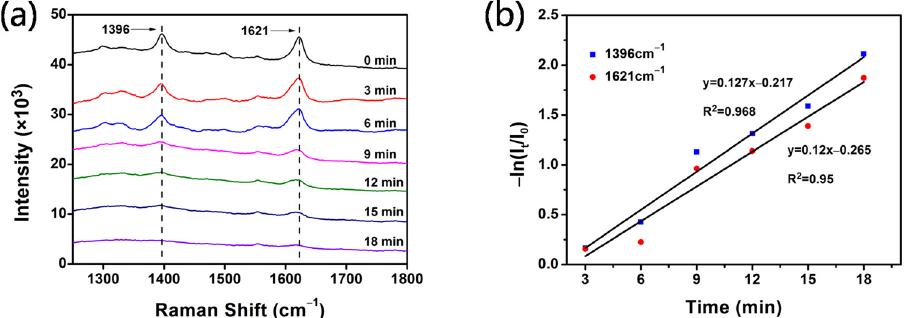
Figure 9. ( a ) SERS signals of MB molecules during the photodegradation reaction by Ag@mTiO 2 nanoparticles. ( b ) The − ln (I t /I 0 ) against reaction time for SERS bands of MB at 1396 and 1621 cm − 1 .